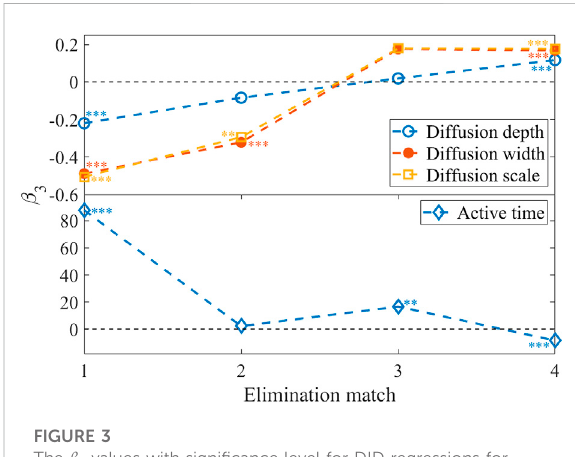
FIGURE 3 The β 3 values with signi fi cance level for DID regressions for diffusion tree